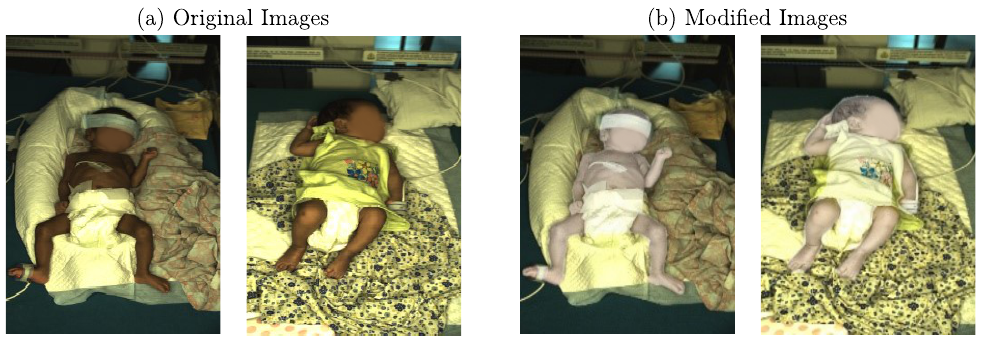
Figure 6. Examples for ( a ) original and ( b ) modified